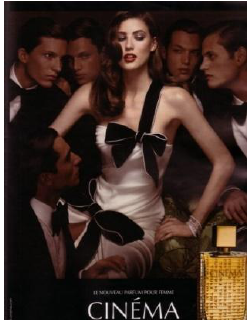
Figure A9. Own selected picture sexy woman.